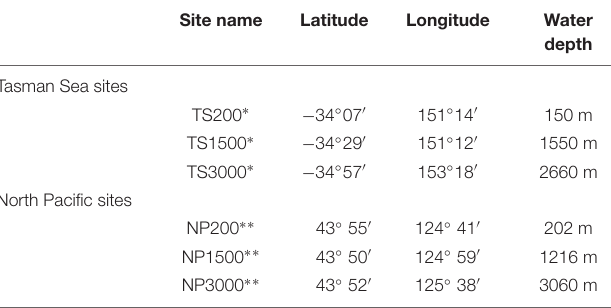
TABLE 1 | Site locations and water